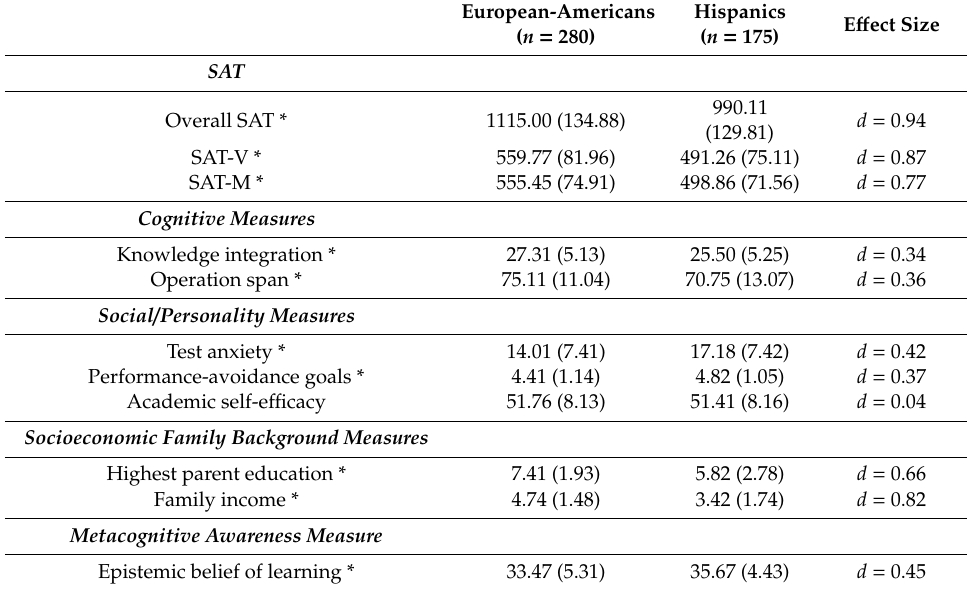
Table 2. Descriptive Statistics for SAT, Cognitive, Social / Personality, Socioeconomic Family Background, and Metacognitive Awareness Measures as a Function of